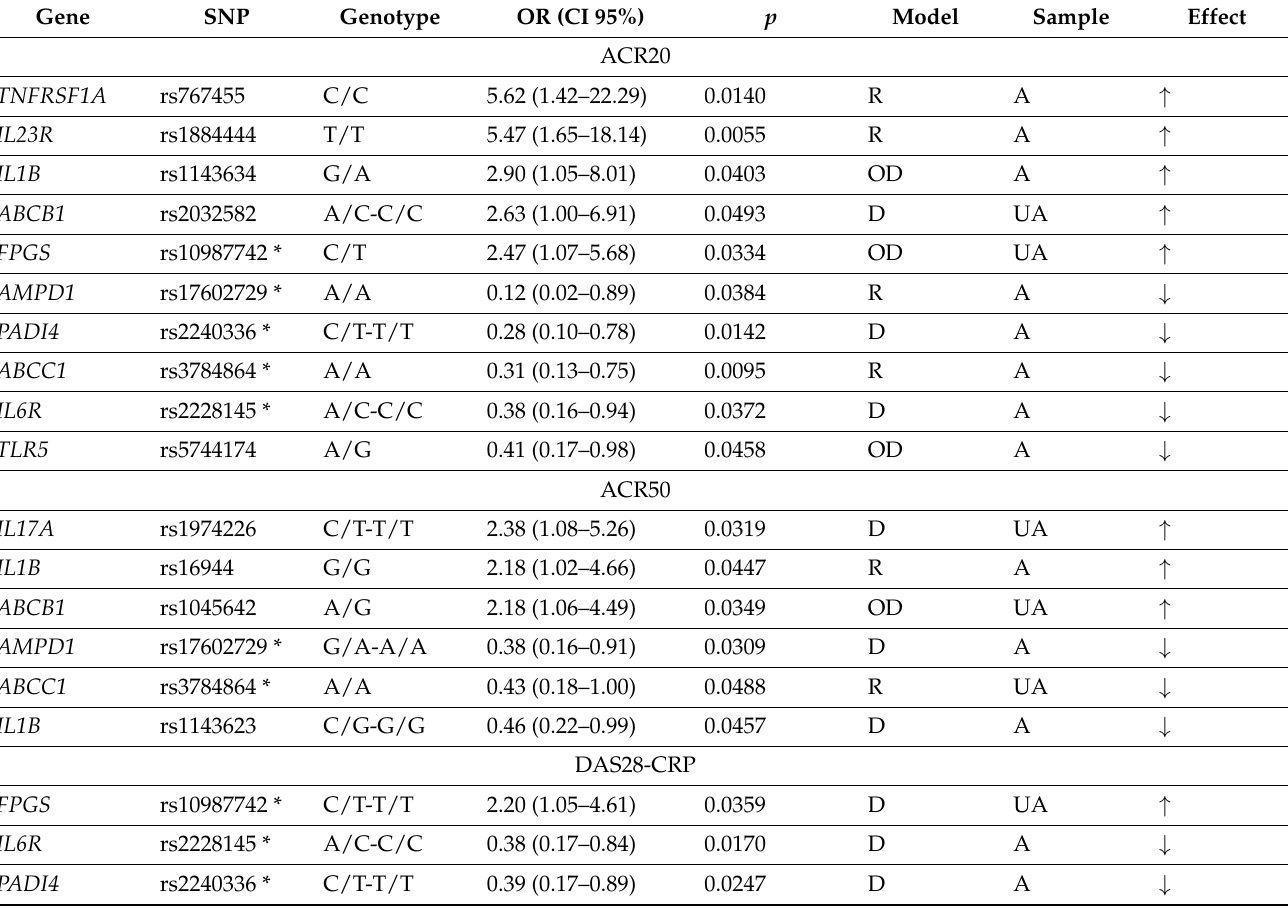
Table 1. Associations of polymorphic variants with the efficacy of olokizumab therapy at week